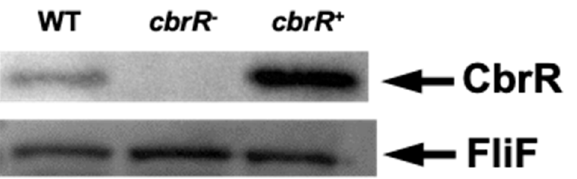
Figure 2. CbrR is absent in a C. jejuni cbrR mutant strain but overexpressed in the complemented strain. Western blots were performed on whole-cell lysates of WT, cbrR mutant ( cbrR − ), and complemented cbrR − mutant ( cbrR + ) cells. Western blots using antibodies to FliF, which is expressed equally in these strains, confirmed equivalent loading of the samples.